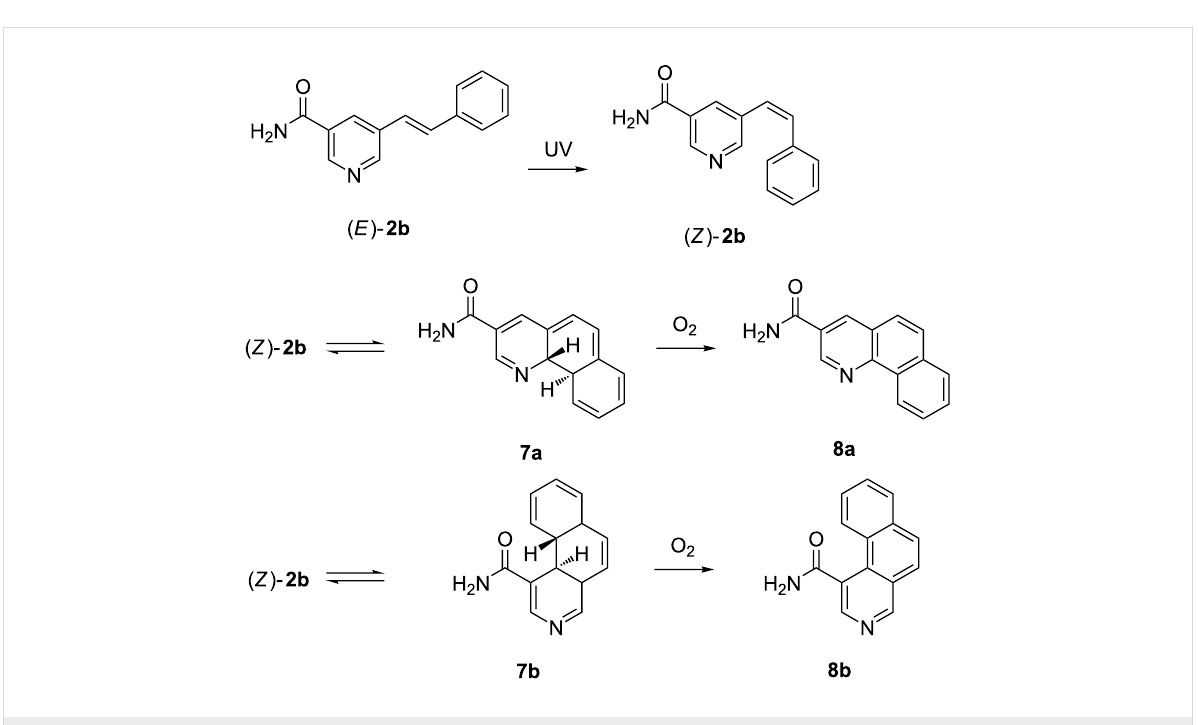
Scheme 3: Photocyclization and oxidation reaction of 2b upon UV